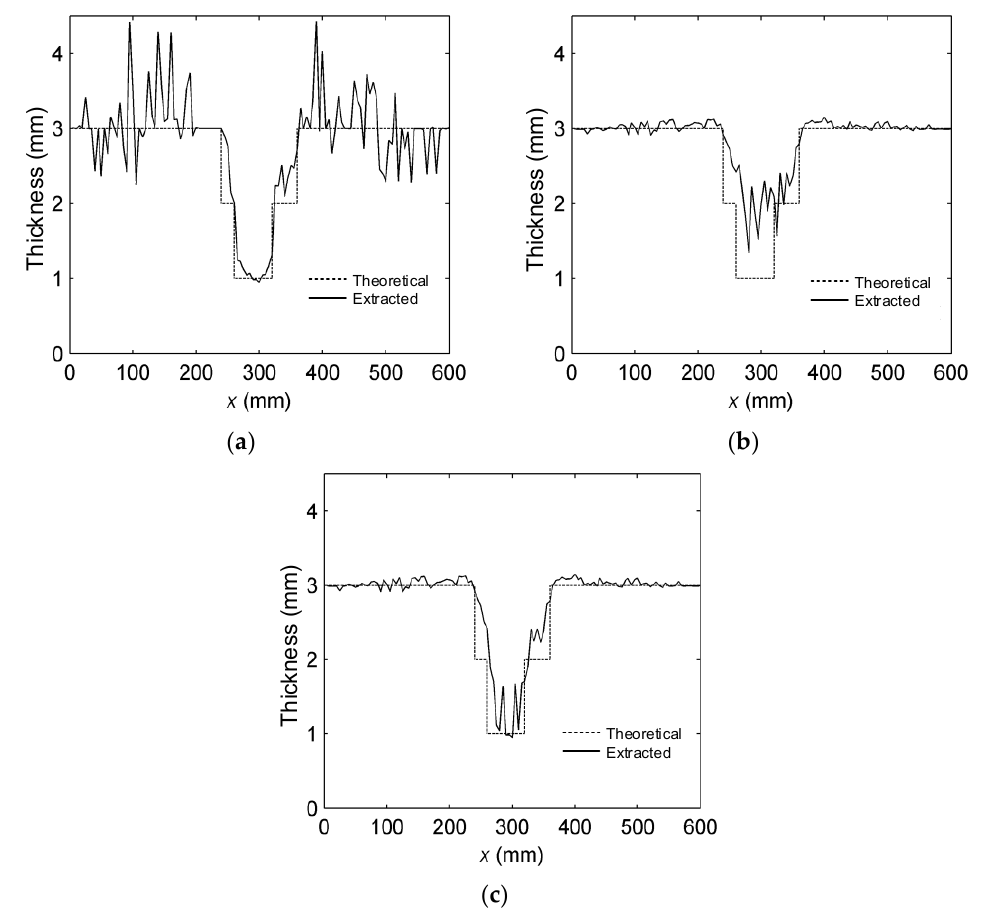
Figure 6. Thickness distribution curves at y = 350 mm from LW CTI. ( a ) Single A0-mode LW CTI; ( b ) single S0-mode LW CTI; and ( c ) multi-mode LW CTI.